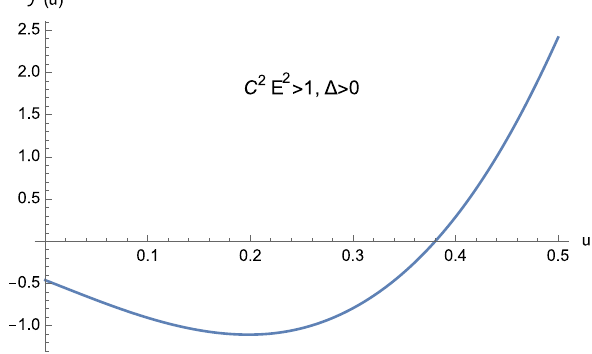
Fig. 7 The positive root of Eq. (2.20) when C 2 E 2 > 1 and (cid:9) > 0